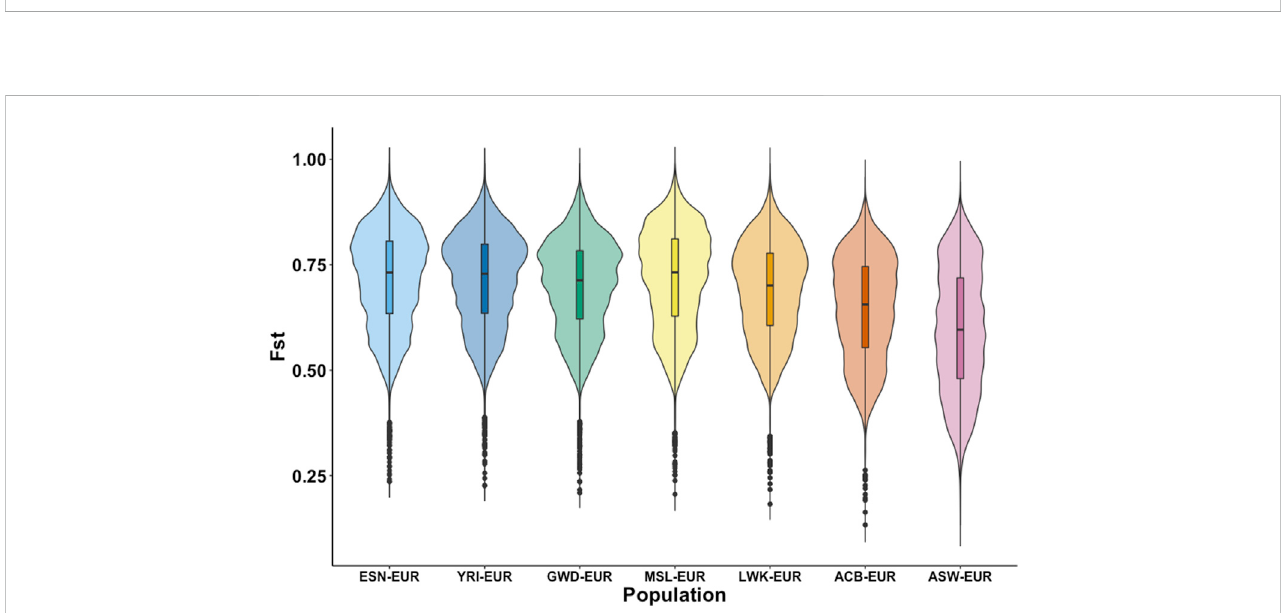
FIGURE 3 Distribution of FST among autosomal AIMs. FST was estimated for each African subpopulation (ESN, YRI, GWD, MSL, and LWK) against the European populationusingdatafromthe1000GenomesProject.Additionally,estimatesofFSTwerealsocalculatedforthetwoothersubpopulationsinthedatasetwith high African ancestry, the Afro-Caribbean population from Barbados (ACB), and African Americans from the United States (ASW). FST was estimated for biallelic autosomal AIMs only and shows differences in the distribution in the FST estimates between the